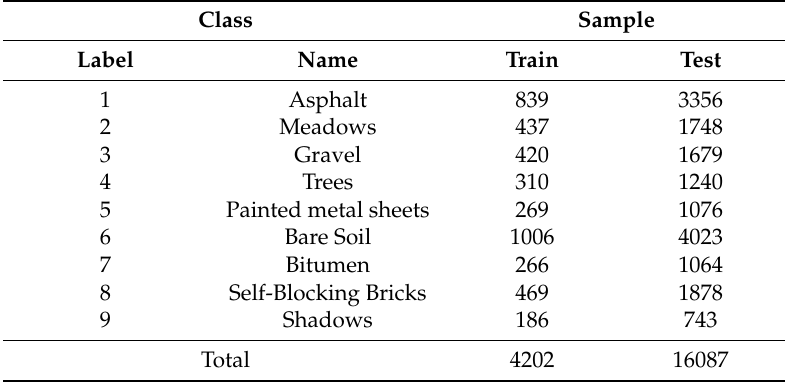
Table 2. The ground truth of training and testing samples in each class for PaviaU